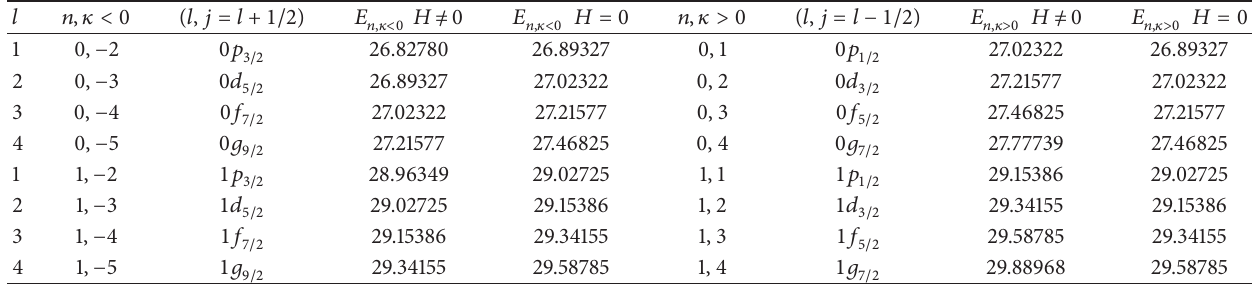
Table 2: The bound state energy eigenvalues in units of fm − 1 of the spin symmetry tPT potential for several values of 𝑛 and 𝜅 with 𝛼 = 0.8 .